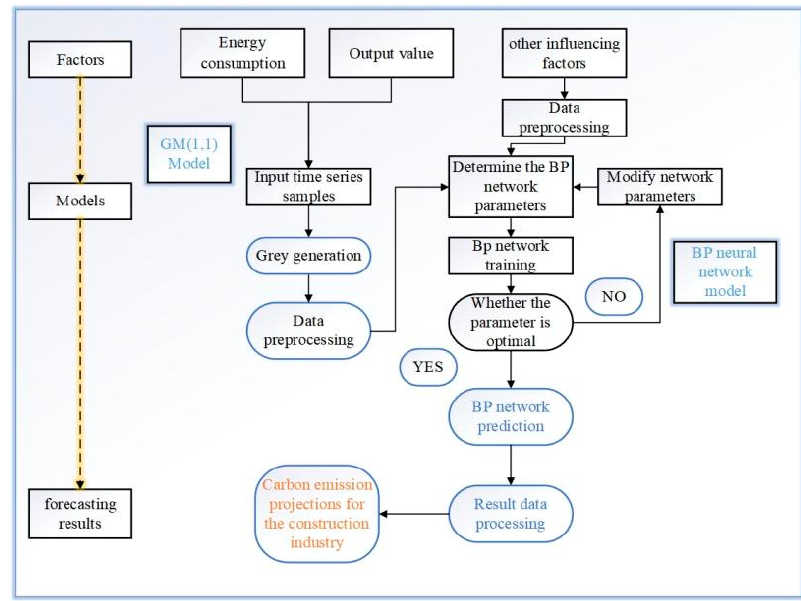
Figure 1. Methodology diagram.